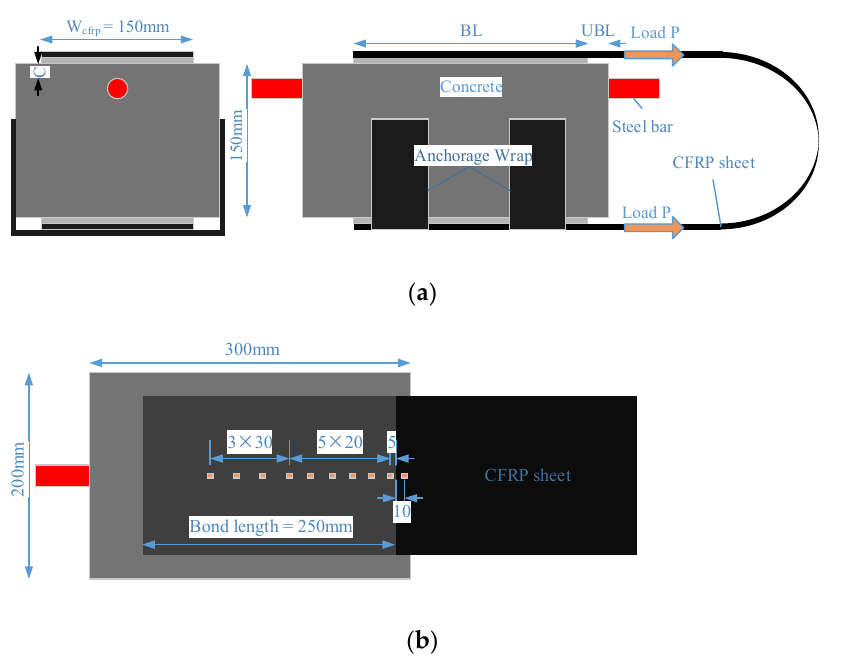
Figure 1. Double shear lap test specimens with detailed dimensions: ( a ) side view; ( b ) top view.